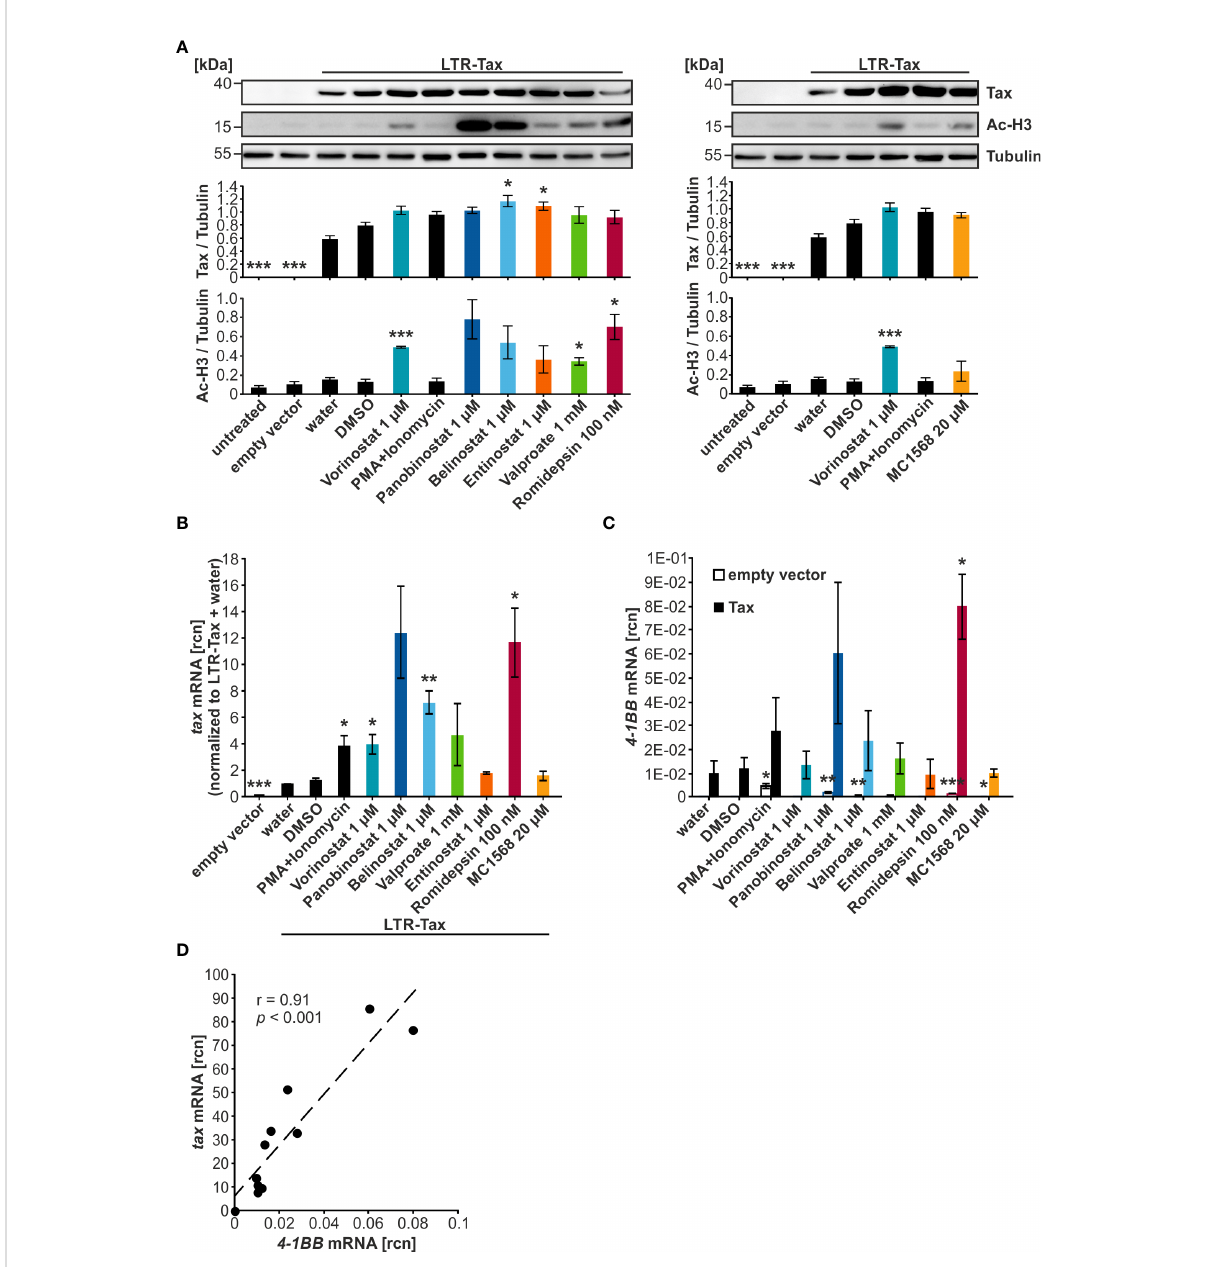
FIGURE 2 HDACi signi fi cantly enhance tax transcription, but only mildly Tax protein expression. (A – D) Jurkat T-cells were transiently transfected with 15 µg of the plasmid LTR-Tax and fi lled with the empty vector DNA pEF1 a to 50 µg. At 24 h after transfection, chemical treatment was carried out for 24 h. PMA+Ionomycin served as a positive control for activation of viral transcription. (A) Western Blot shows Tax protein, acetylated histone H3 (Ac-H3), and a -Tubulin (Tubulin) as the loading control. Densitometric analysis of Tax protein expression, and Ac-H3, relative to Tubulin, of three independent experiments, was performed. Mean values of three independent experiments ± SE are depicted and were compared using Student ’ s t-test (* p < 0.05 relative to respective solvent control). (B) Fold change of relative copy numbers (rcn) of tax , normalized to the housekeeping gene b -Actin and LTR-Tax and water, of three independent experiments ± SE is displayed and was compared using Student ’ s t- test (* p < 0.05; ** p < 0.01; *** p < 0.001, relative to the respective solvent control; empty vector was compared to LTR-Tax and water). (C) Mean rcn of 4-1BB , normalized to the housekeeping gene b -Actin , of three independent experiments ± SE was compared to the respective solvent control-treated cells using Student ’ s t-test (* p < 0.05; ** p < 0.01; *** p < 0.001) in empty vector (clear outlined bars) or LTR-Tax-transfected (black and colored bars) Jurkat T-cells. (D) Mean rcn of tax and 4-1BB , normalized to the housekeeping gene b -Actin , were correlated and subjected to Pearson correlation analysis (Pearson correlation coef fi cient r = 0.91; p =